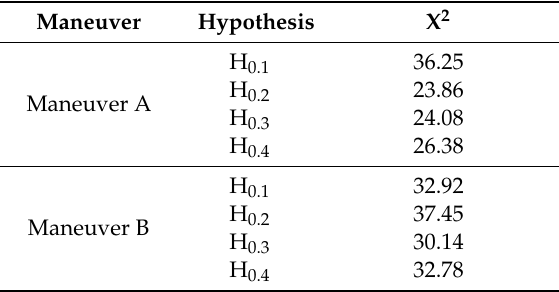
Table 5. Results from the X 2 -test for both